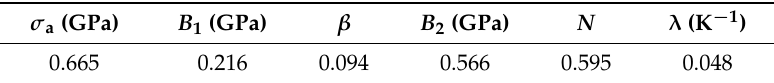
Table 3. Material constants of the modified Zerilli and Armstrong constitutive relation constitutive model